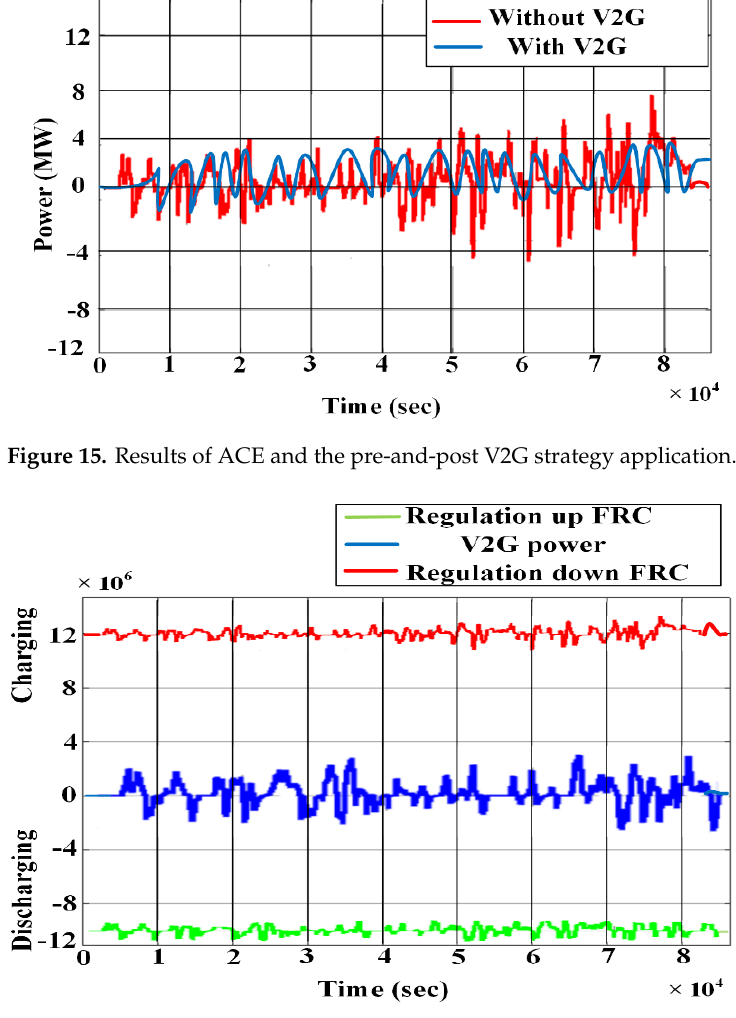
Figure 17. PFC of industrial microgrid without V2G and with V2G.